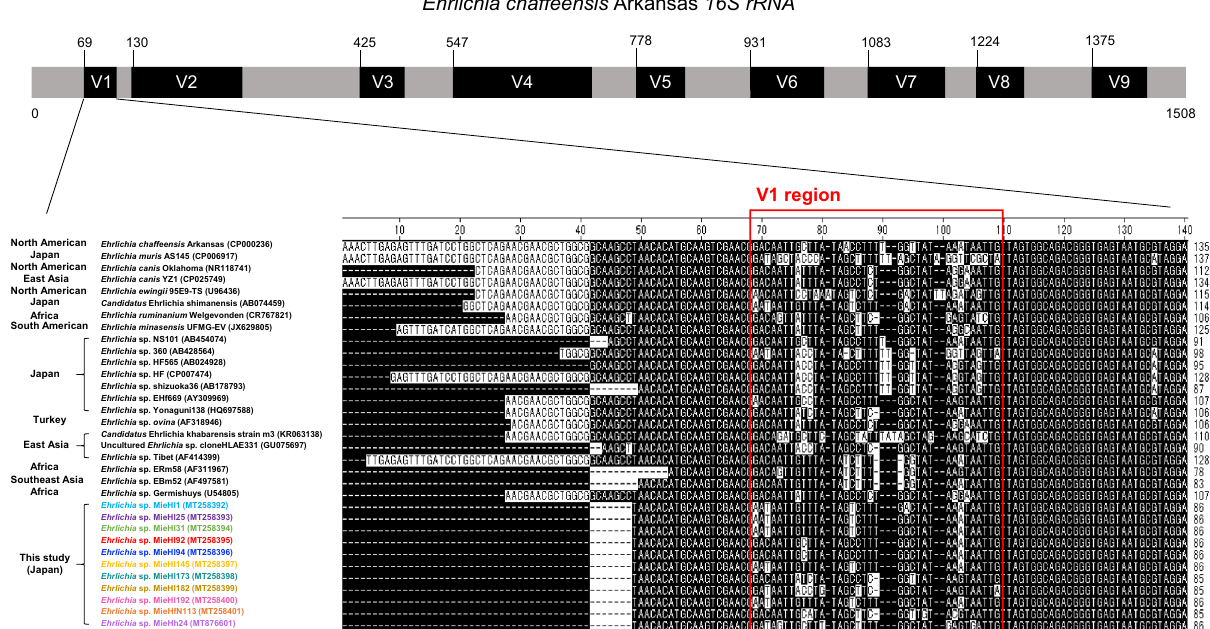
Figure 3. Alignment of the V1 region of 16S rRNA sequences from 33 Ehrlichia bacteria, including 11 uncultured ehrlichiae, in this study. The V1 region of the Ehrlichia 16S rRNA alignment is boxed with a red line.